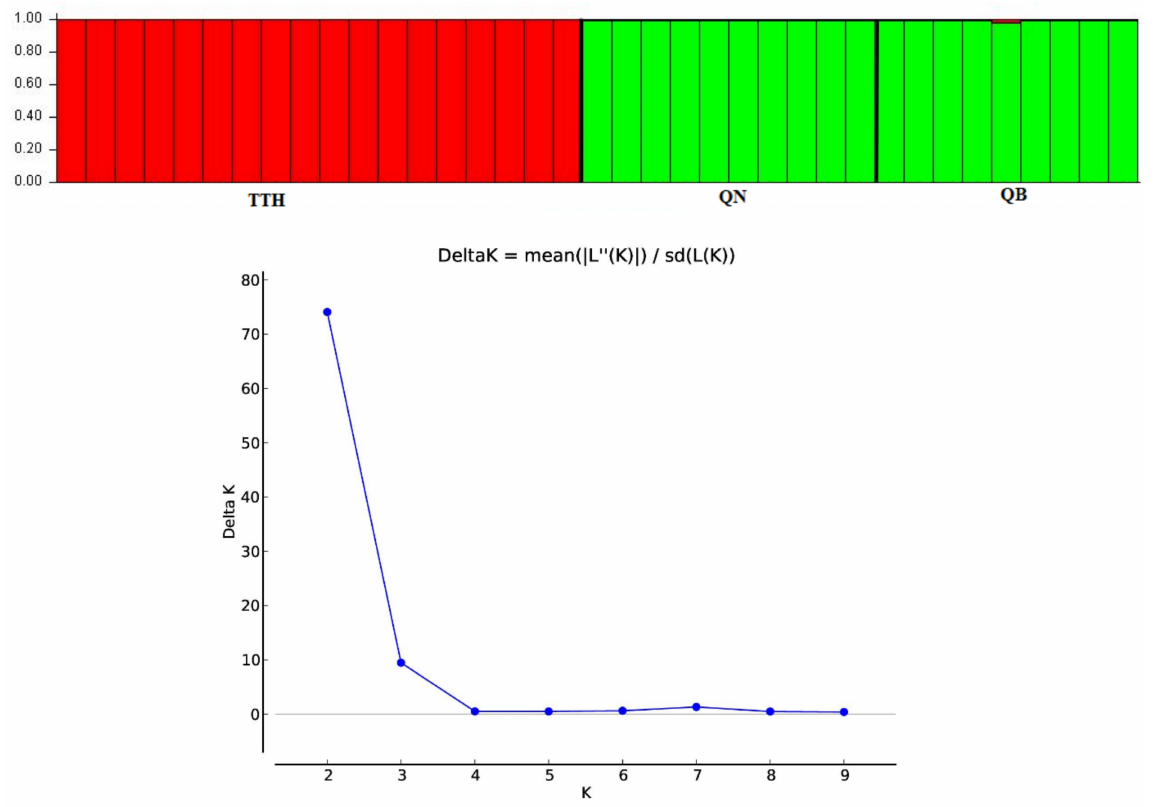
Figure 7. Delta K distribution graph and bar plot of the admixture assignment for three M. officinalis populations to clusters (K = 2; highest ∆ K value = 74.084117) based on Bayesian